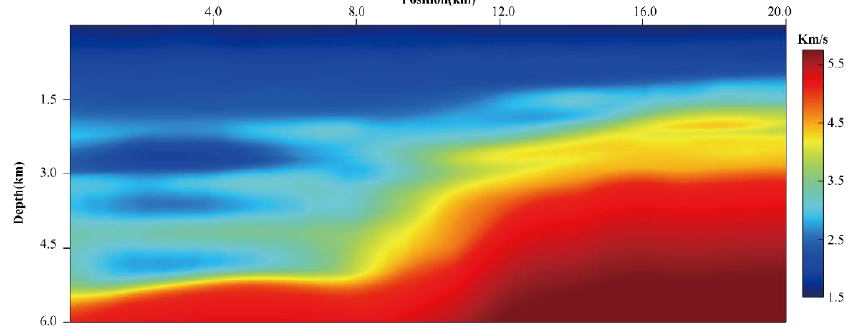
Figure 11. The migration velocity model from a marine field data.